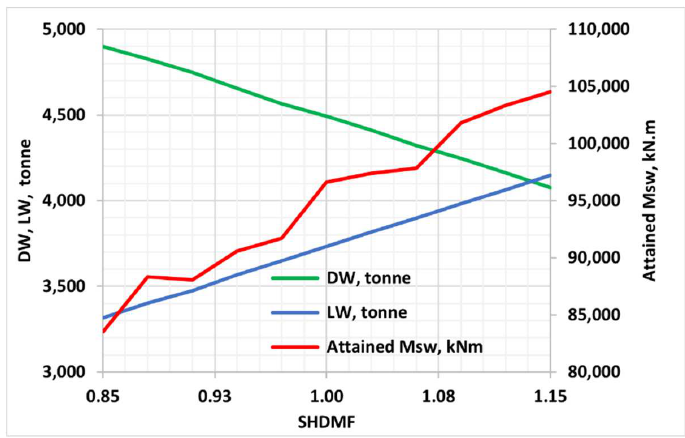
Figure 7. LW, DW and steel water vertical bending moment, Msw at midship section.